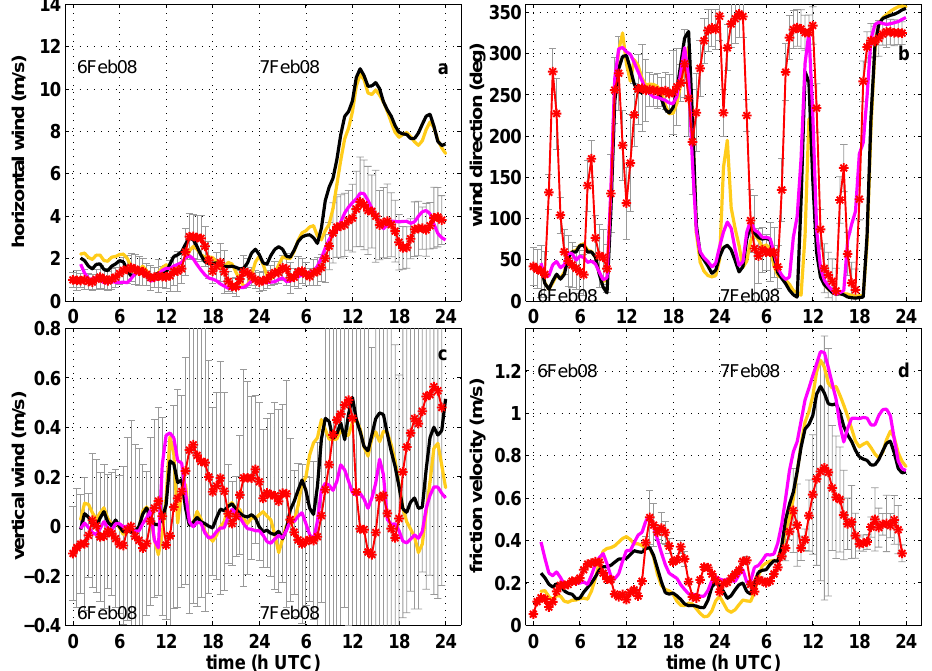
Fig. 5. Time series of horizontal wind speed (a) , and direction (b) , vertical wind (note: model results are multiplied by a factor of 10) (c) , friction velocity (d) for 6–7 February 2008. Color code: MYJtd is orange; MYJNoahNOURB is black; MYJNoahUCM2 is pink; anemometer measurements are red; and errors are